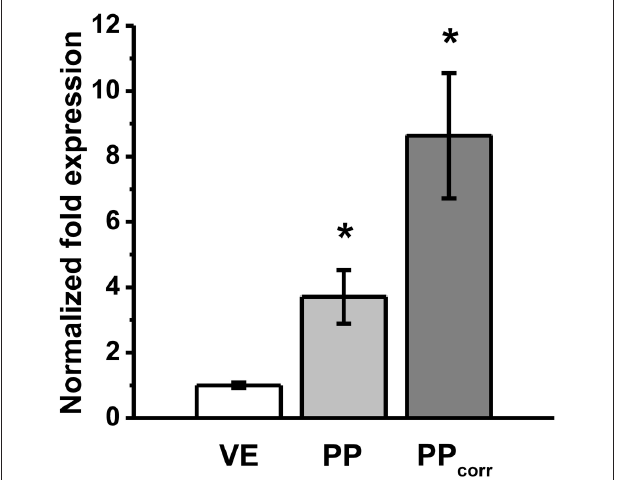
FIGURE 5 | RT-qPCR revealed increased levels of mRNA expression of claudin-4 in Peyer’s patch follicle associated epithelium (PP FAE) tissue specimens vs. villous epithelium (VE). Normalized fold expression was calculated by the 11 Ct method. * P < 0.05, n = 3,